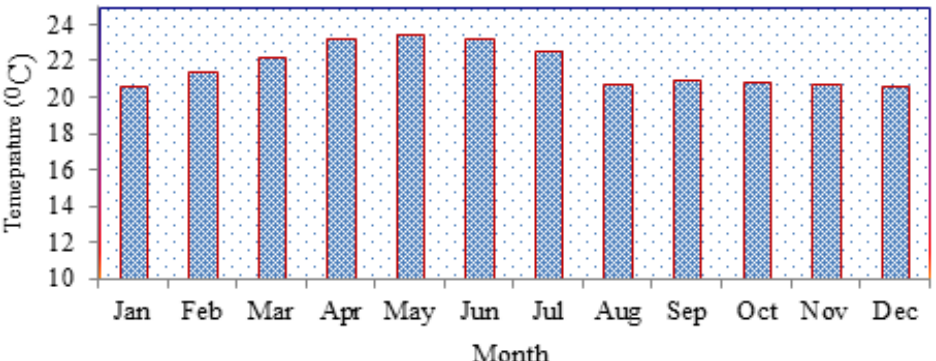
Figure 6. Monthly average ambient temperature values for the investigated site.